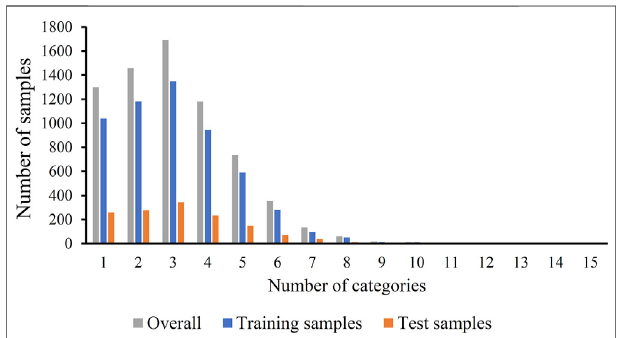
FIGURE 1 | Distribution of training, test and overall samples based on the number of categories that they belong to. Several samples belong to two or more